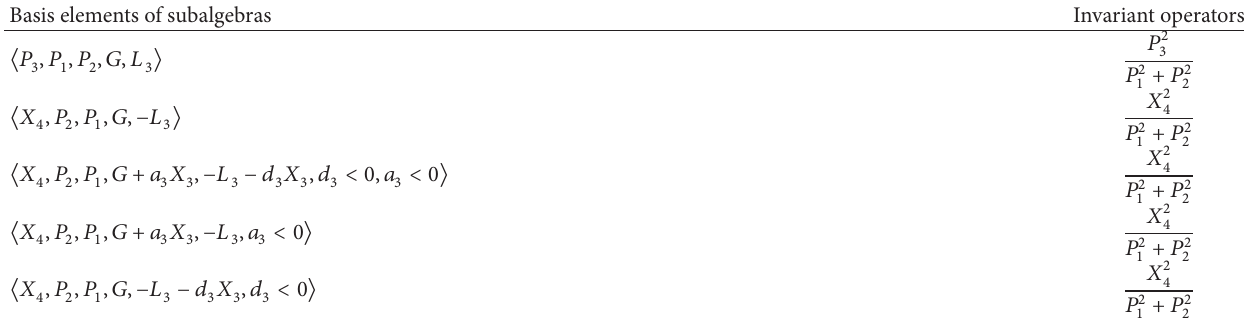
Table 29: Invariant operators of subalgebras of the type 𝐴 𝑎𝑏 5,35 (𝑎 = 0, 𝑏 = 1) . Basis elements of